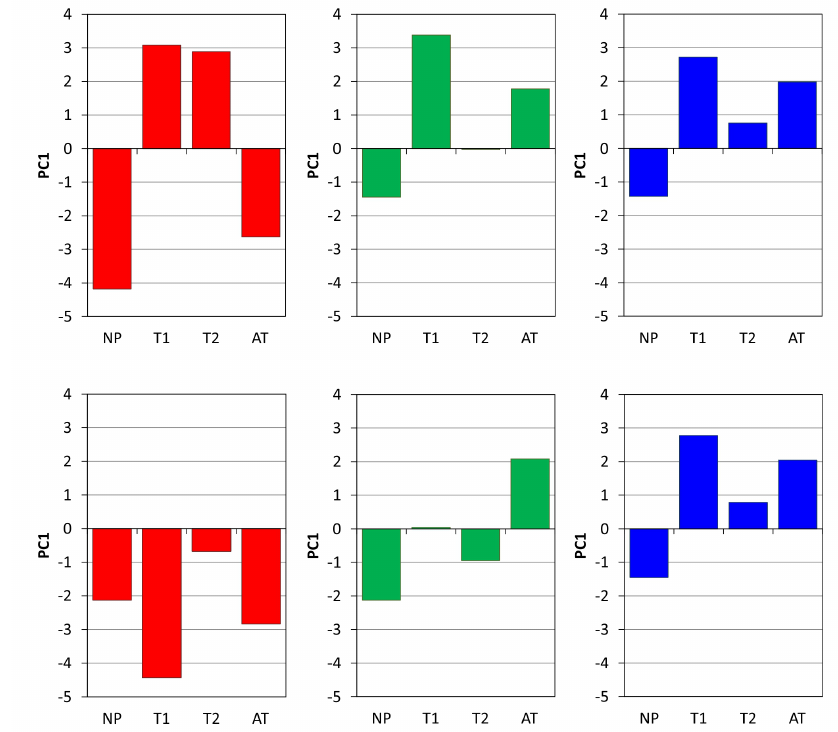
Figure 11. Plots of the PC 1 component in the function of different pilling tests for various fabric types: F 1, F 2, F 3—tested fabrics; F 1 a , F 2 a , F 3 a —tested fabrics after the laser ablation; NP —not pilled (control) sample; T 1, T 2—manual tests; AT —apparatus